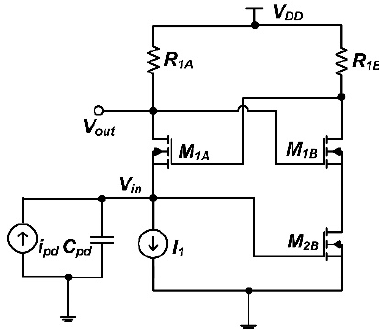
Figure 2. Cross-coupling single-ended TIA design with RGC input design as in [14].